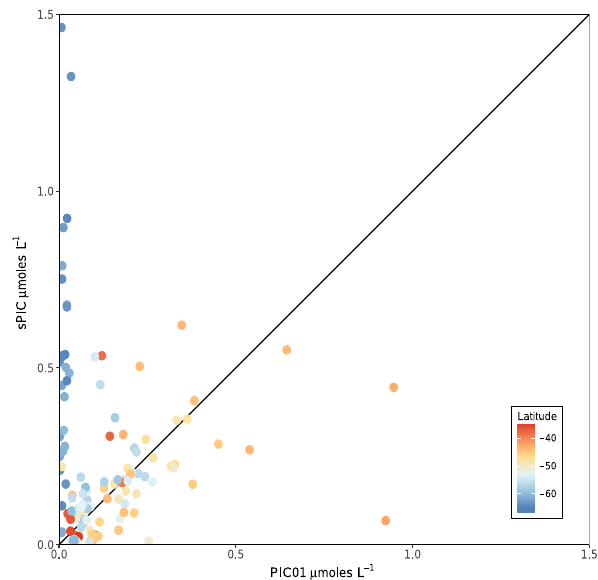
Figure 6. Comparison of satellite SPIC and ocean PIC concentra- tions for the 116 matchups for which satellite SPIC estimates were available within 25km of the ocean PIC sample sites, on the same day. Colours indicate sample latitudes and show that good correla- tion occurs in subantarctic waters, but there is a strong overestima- tion by the satellite technique in Antarctic